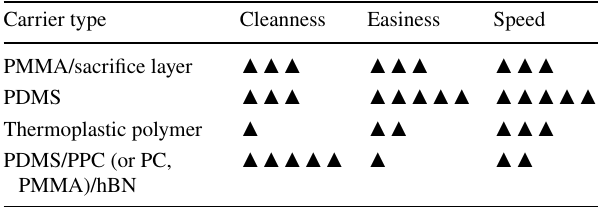
Table 1 Comparison between the different deterministic placement methods 1 . Reprinted with permission from Ref. [25]